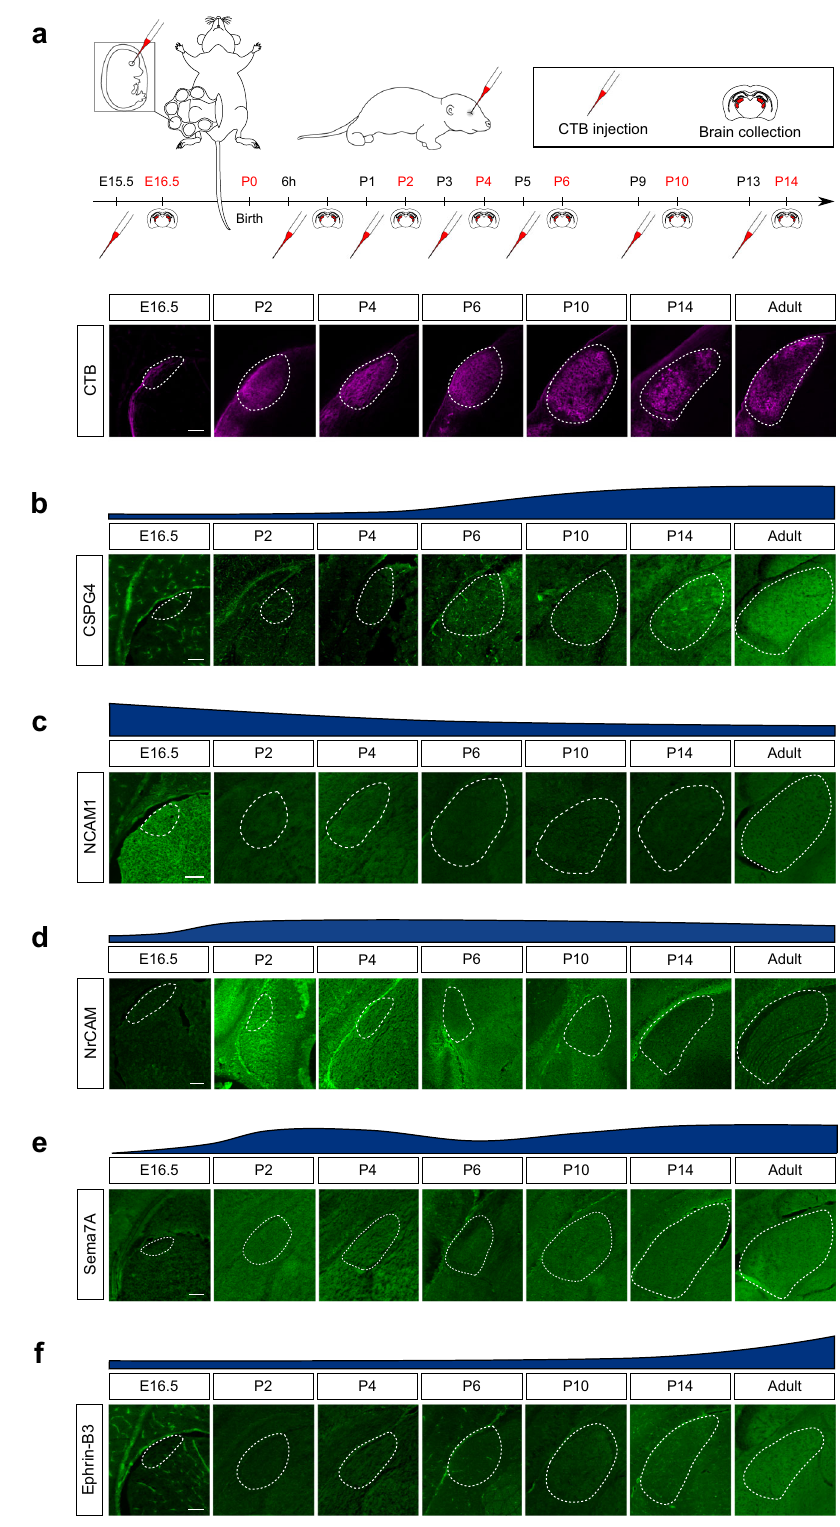
Fig. 5 | The guidance map is established during innervation of the developing visual target regions. a Schematic drawing showing in utero injection of mouse embryo eye at E15.5 and postnataleye injection. Experimentaldesignand timeline, and representative epi fl uorescent images of CTB-labelled dLGN at the different timepoints.ForP2toP14time-points:onedaybeforesamplecollection,oneeyeof mouse pups was injected intravitreally with CTB-555. For P0 time-point: 6h before